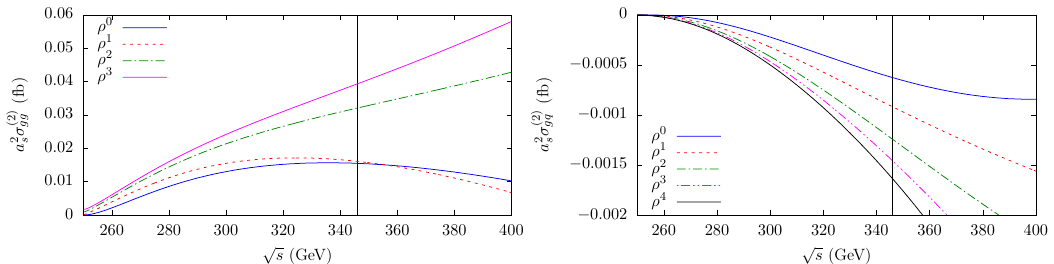
Figure 4: NNLO contributions to the total cross sections of the g g and gq channels. The vertical black line shows the threshold at orders in the large- m